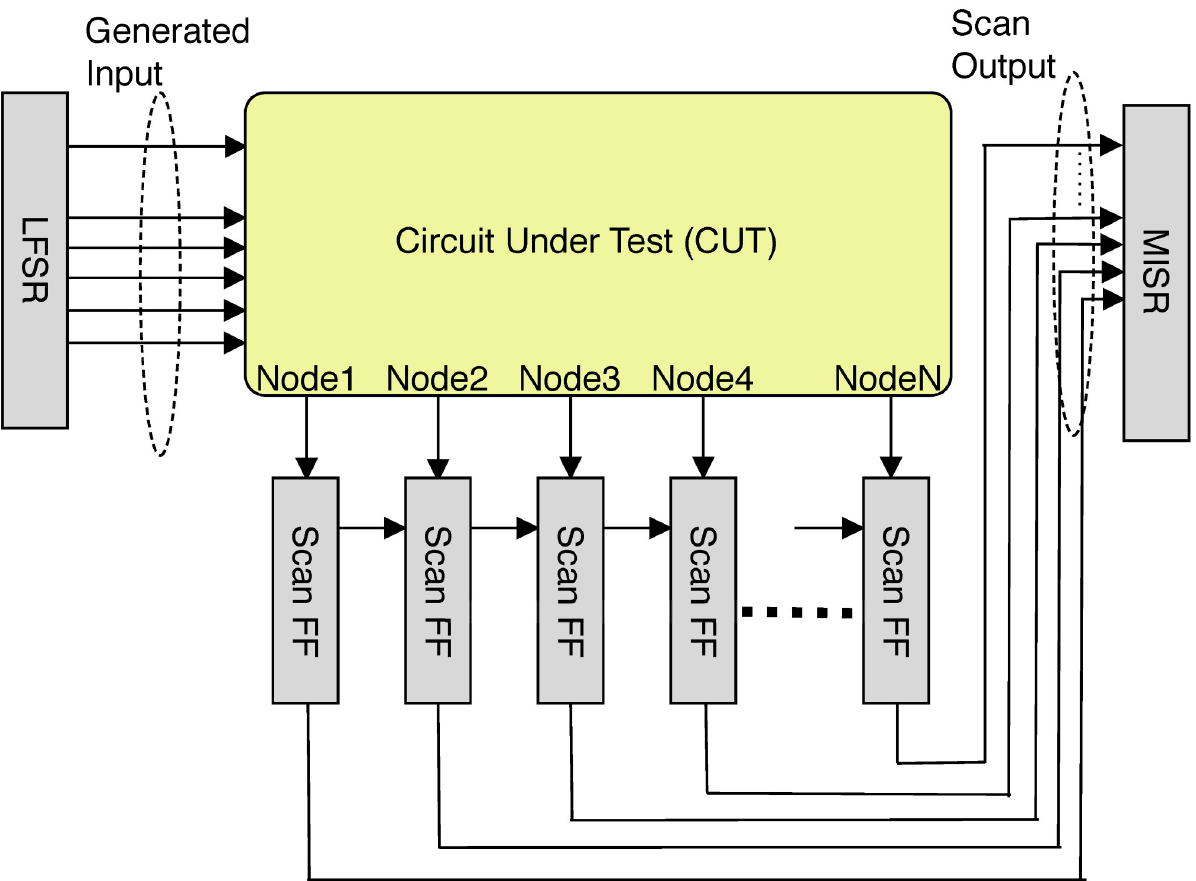
Fig 1. A general dual-mode self-test (DMST)